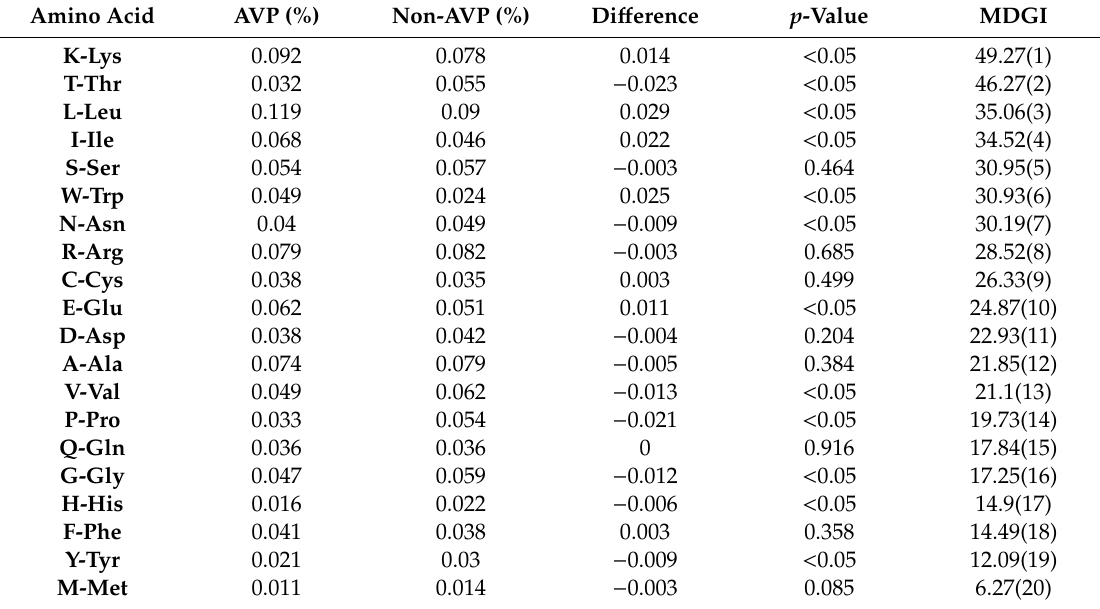
Table 2. Amino acid compositions (%) of AVP and Non-AVP along with their mean decrease of Gini index (MDGI) values on T 544p + 407n dataset.